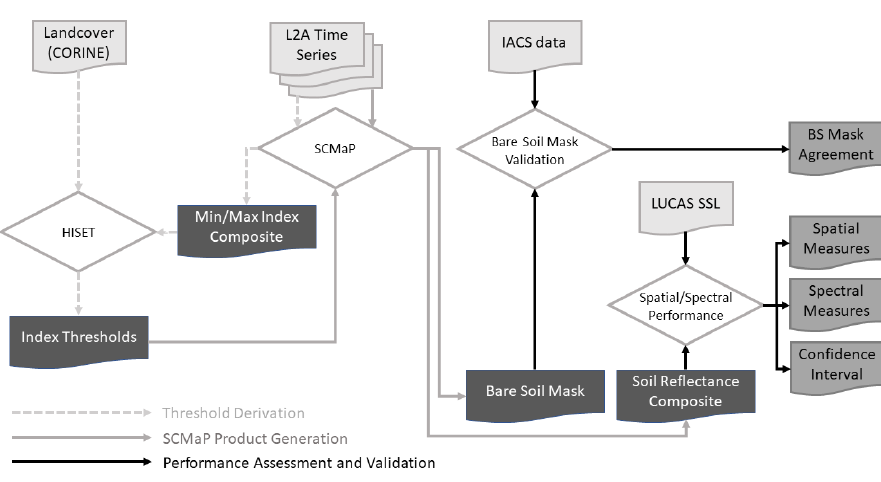
Figure 1. Summary of the main analyses and processing steps carried out in this study; BS = Bare